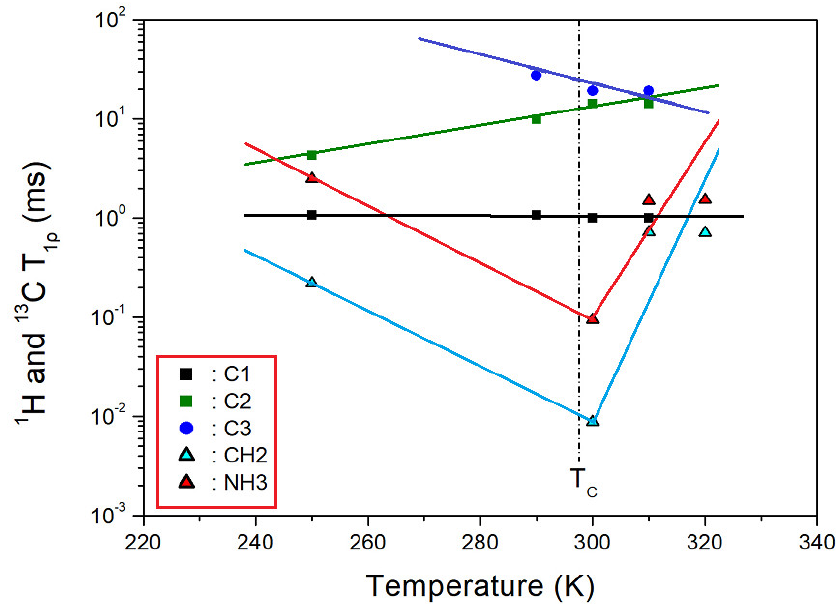
Figure 9. Spin-lattice relaxation times t 1ρ for 1 H and 13 C of [NH 3 (CH 2 ) 5 NH 3 ]MnCl 4 near T C .